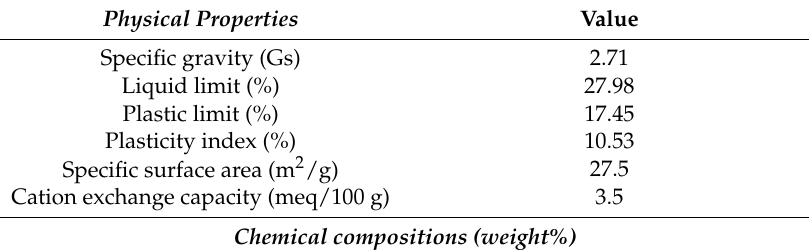
Figure 1. Particle size distribution of raw loess. Table 1. Physical properties and chemical compositions of loess used in this study.